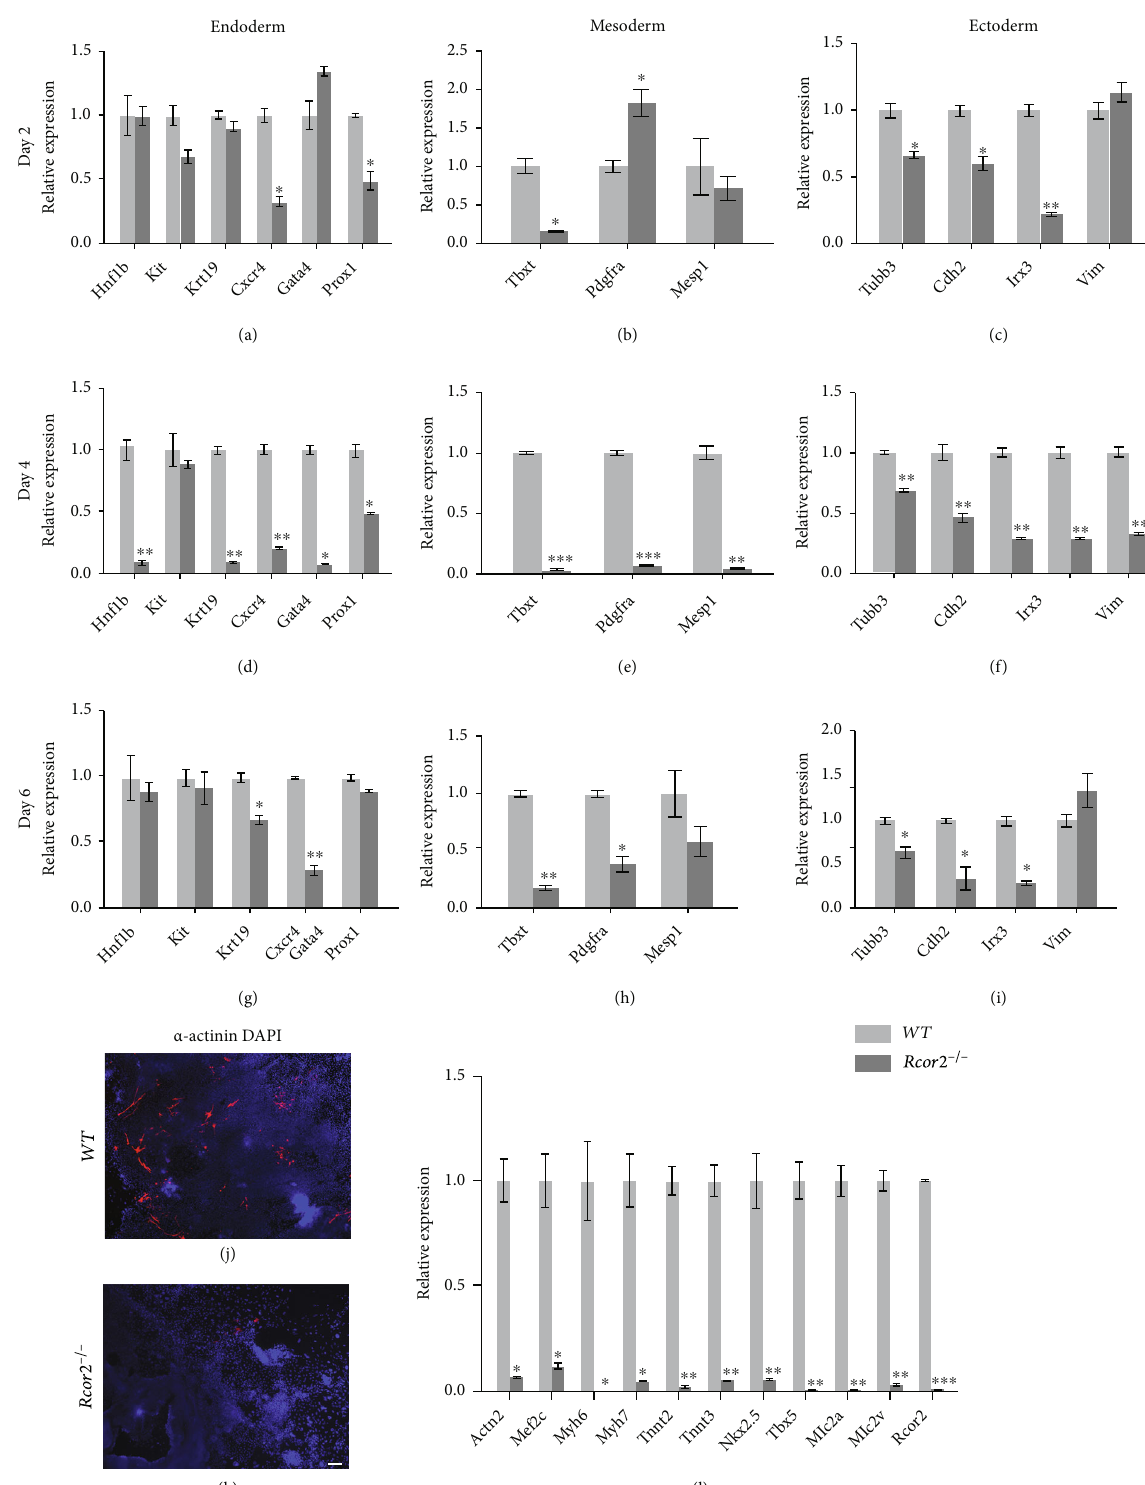
Figure 2: Rcor2 is required for di ff erentiation of all three germ layers. (a – i) Relative expression of endoderm (a, d, g), mesoderm (b, e, h), and ectoderm (c, f, i) speci fi c genes in WT mESC-derived cells and Rcor2 -/ - mESC-derived cells at day 2 (a – c), day 4 (d – f), and day 6 (g – i) of spontaneous random di ff erentiation. (j, k) Immuno fl uorescence staining for DAPI (blue) and α -actinin (red) in WT (j) and Rcor2 -/- (k) mESC-derived cells at day 9 of di ff erentiation. Scale bars, 100 μ m. (l) Relative expression of cardiomyocyte maker genes in WT mESC- derived cells and Rcor2 -/- mESC-derived cells at day 9 of di ff erentiation. Data are expressed as mean ± SEM , n = 3 , ∗ p < 0 : 05 , ∗∗ p < 0 : 01 , ∗∗∗ p < 0 : 001